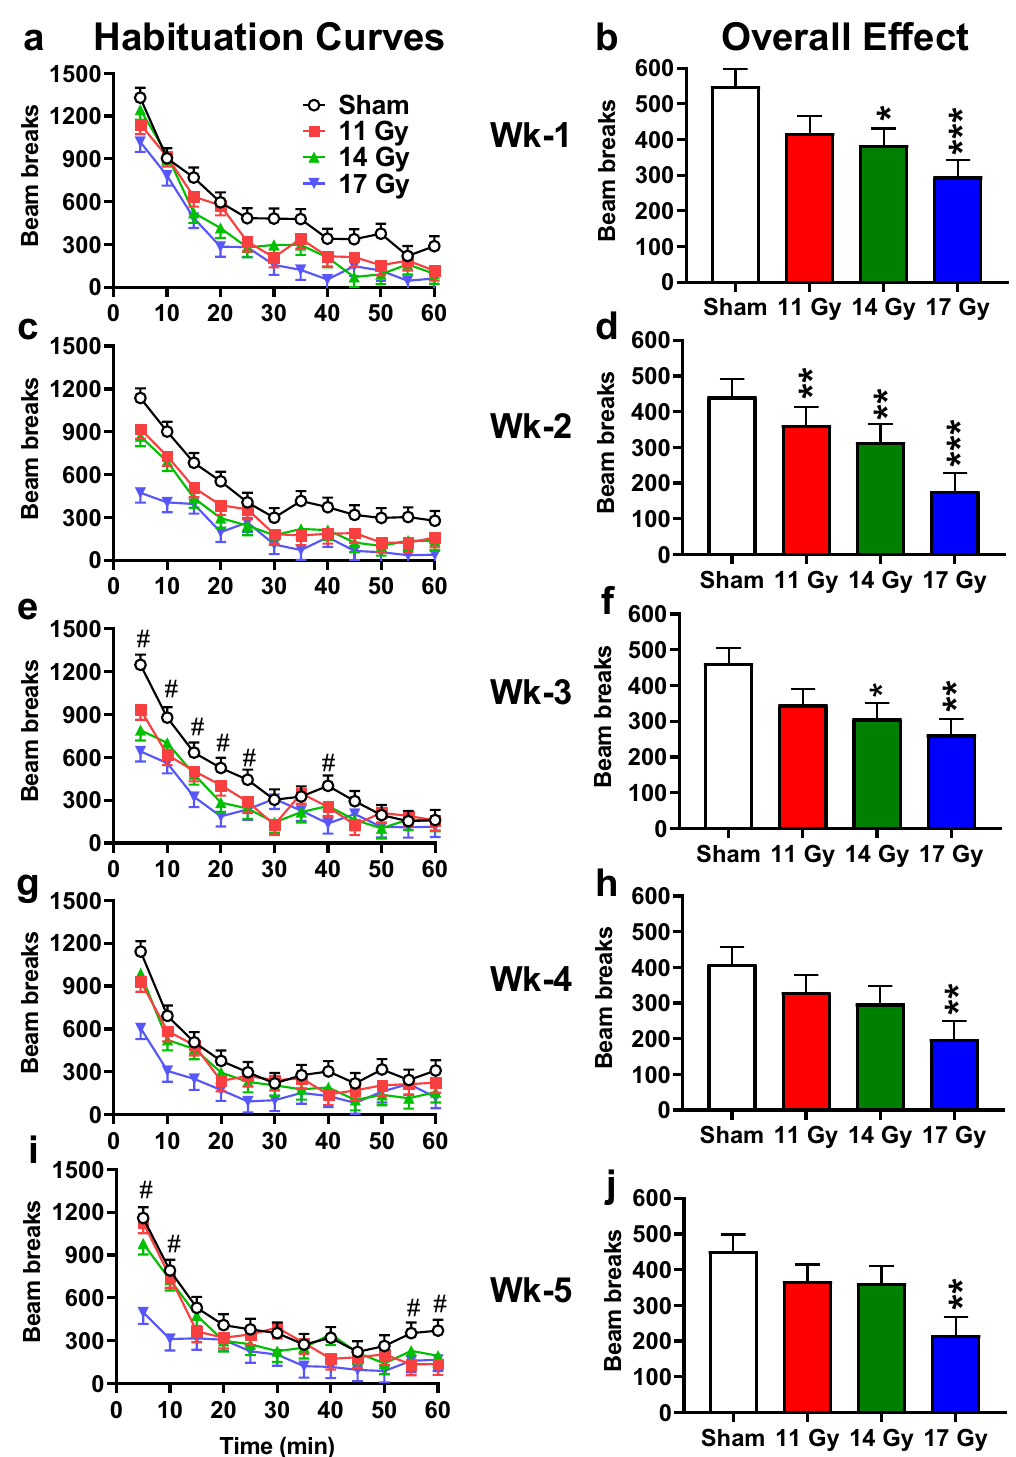
Figure 2. Weekly locomotor activity in proton irradiated and control rats. ( a ) Week-1 habituation curve. ( b ) Week-1 overall effects. ( c ) Week-2 habituation curve. ( d ) Week-2 overall effects. ( e ) Week-3 habituation curve. ( f ) Week-3 overall effects. ( g ) Week-4 habituation curve. ( h ) Week-4 overall effects. ( i ) Week-5 habituation curve. ( j ) Week-5 overall effects. For week 3 and 5 there were interactions. # week-3 ( e ) 11 Gy rats had reduced locomotion at 5-min, 14 Gy at 5 and 20 min, and 17 Gy at 5–25 and 40 min compared with controls. # week-5 ( i ) 11 Gy rats had reduced locomotion at 55 and 60 min and 17 Gy at 5–10 min compared with controls. * p < 0.05, ** p < 0.01, *** p < 0.001 compared with controls. N = 10/group for all time points except at Week-4 for the 17 Gy, n =